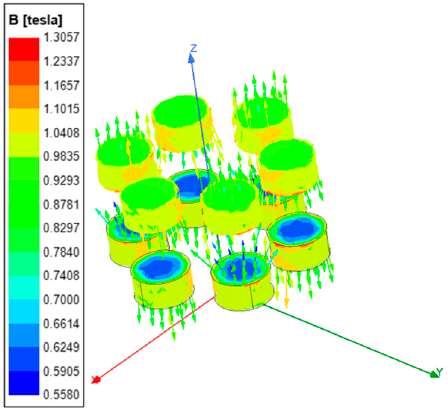
Figure 9. Finite element simulation model of the electromagnetic damper: ( a ) Simplified model; ( b ) Central cross section of the stator disk.